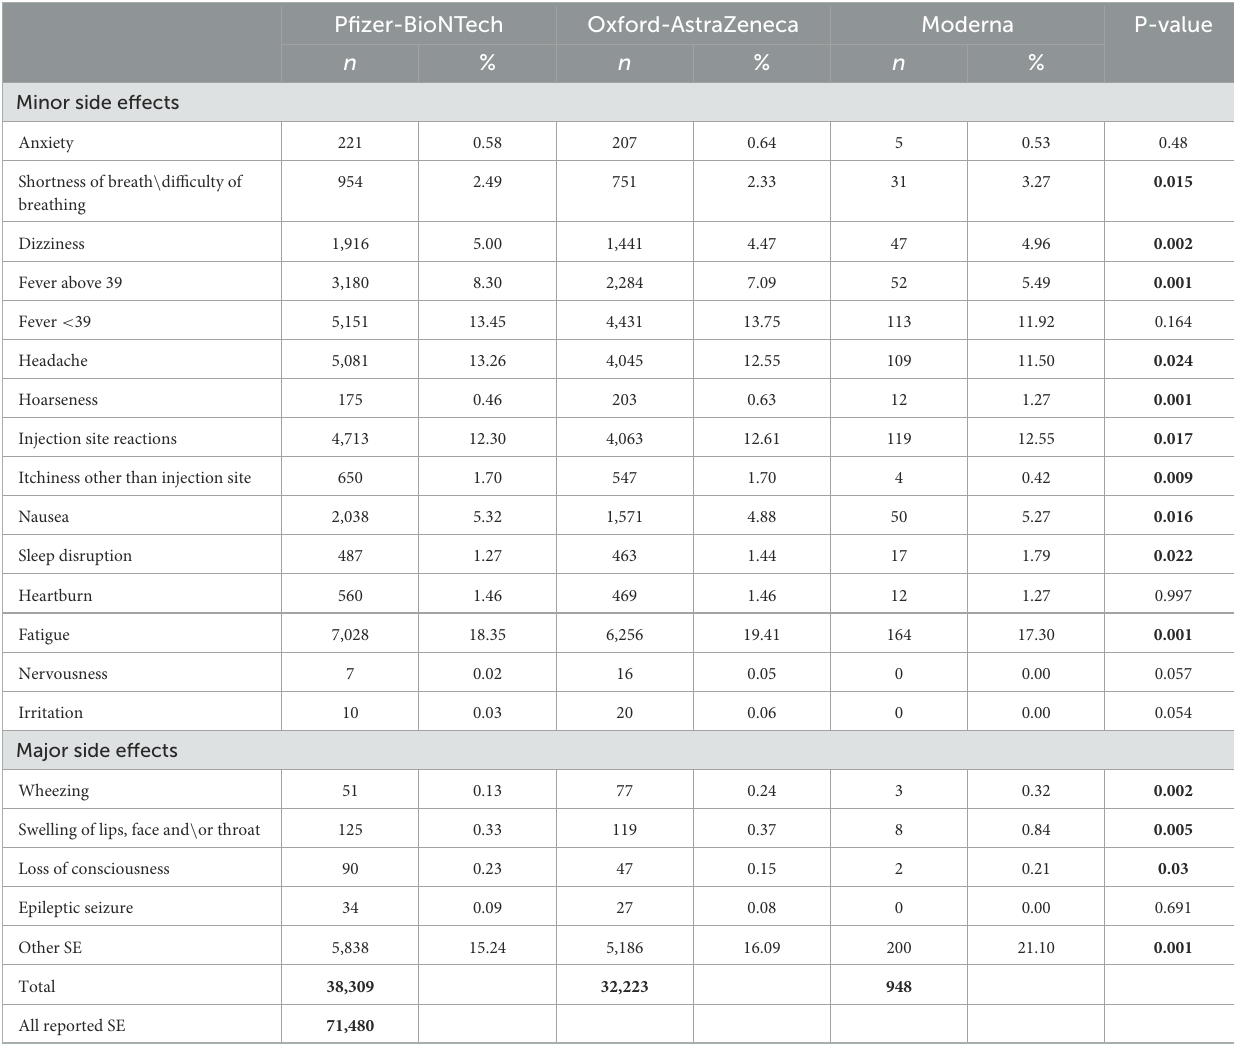
TABLE 2 Adverse events in relation to the type of vaccine received. Pfizer-BioNTech Oxford-AstraZeneca Moderna